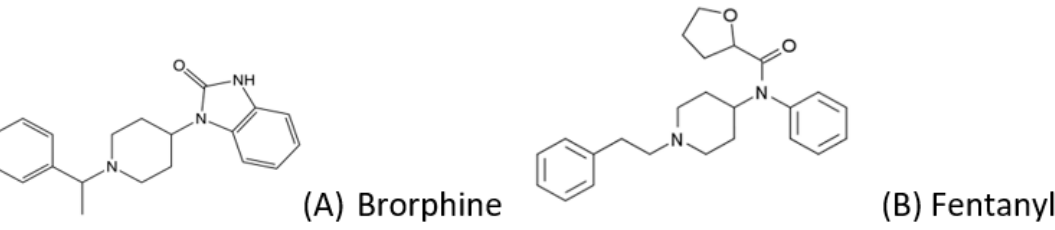
Figure 1. Chemical structure of ( A ) brorphine (MW 436.8, pKa 6.61), and ( B ) fentanyl (for comparison).